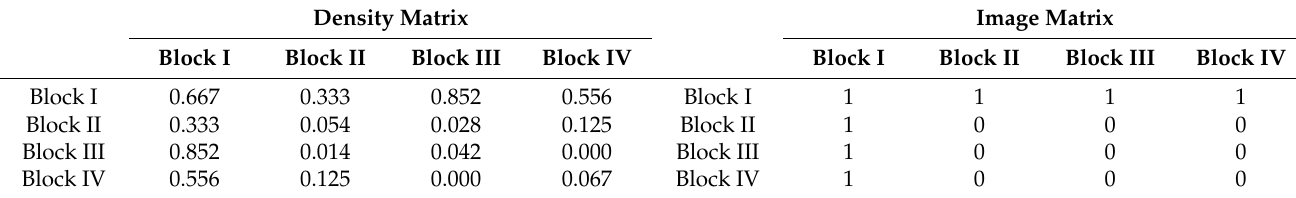
Table 5. Density and image matrixes of spatially related blocks of tourism eco-efficiency. Density